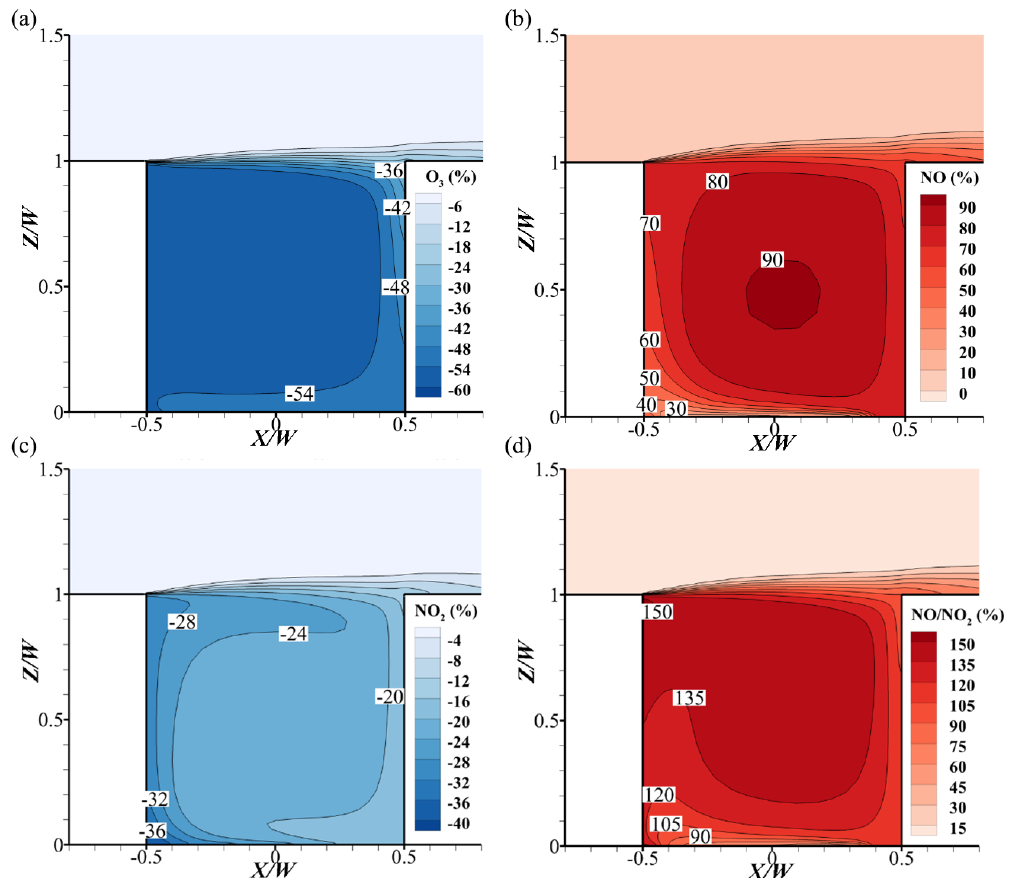
Figure 15. Change rate of (a) O 3 , (b) NO, (c) NO 2 , and (d) NO / NO 2 between the simple chemistry and full chemistry mechanisms.